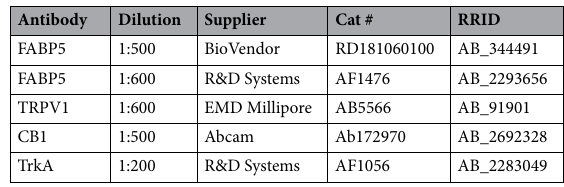
Table 1. Primary antibodies used in the current